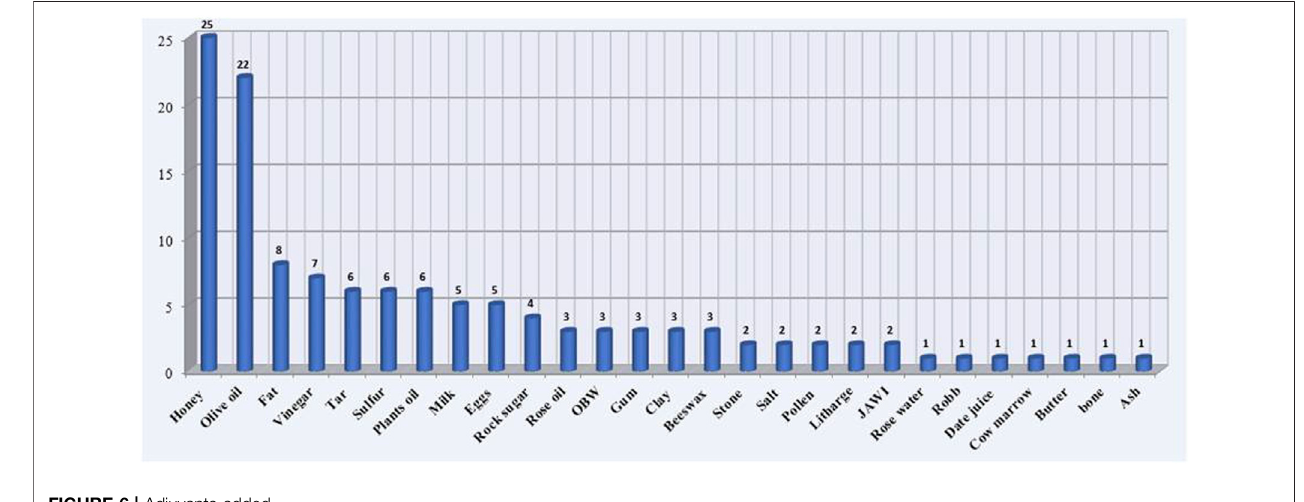
FIGURE 6 | Adjuvants added.